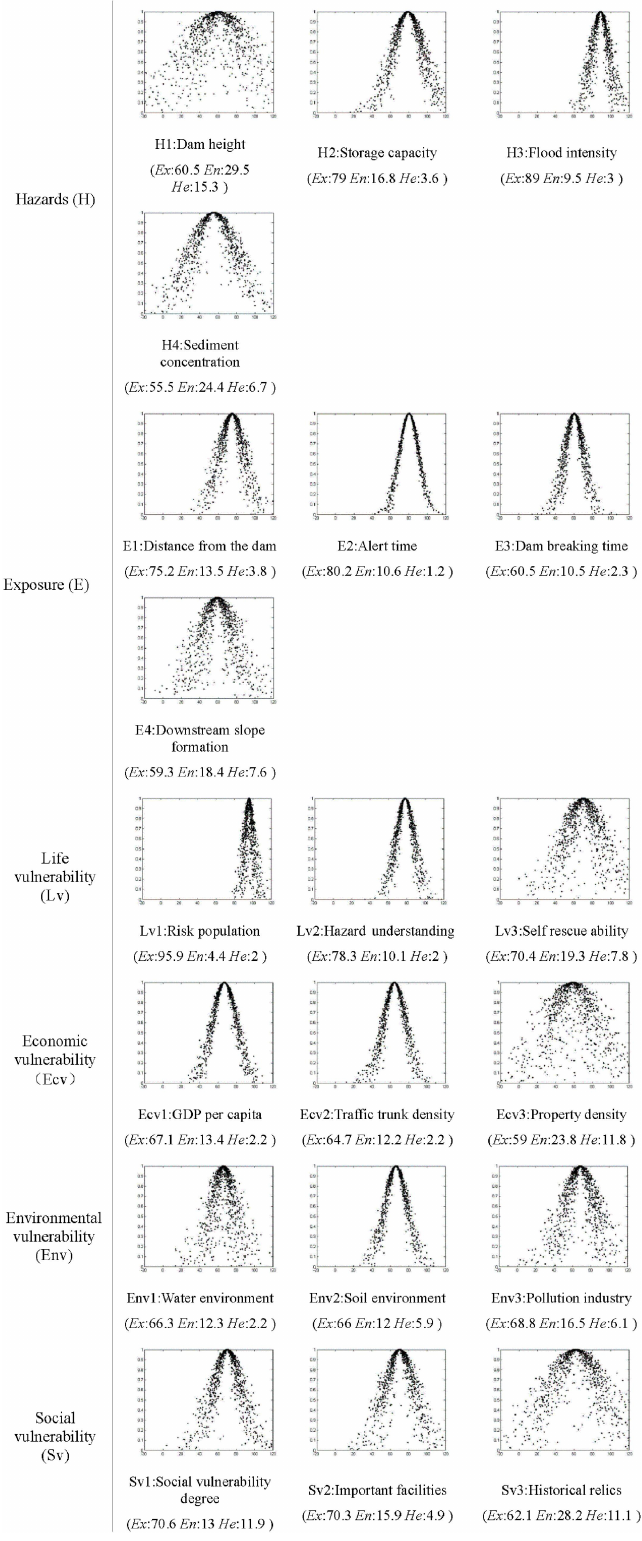
Figure 3. Sketch map of 20 indexes’ membership